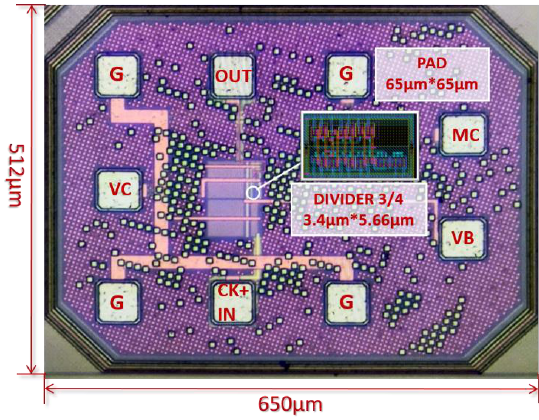
Figure 6. Die photo of the divider test chip.